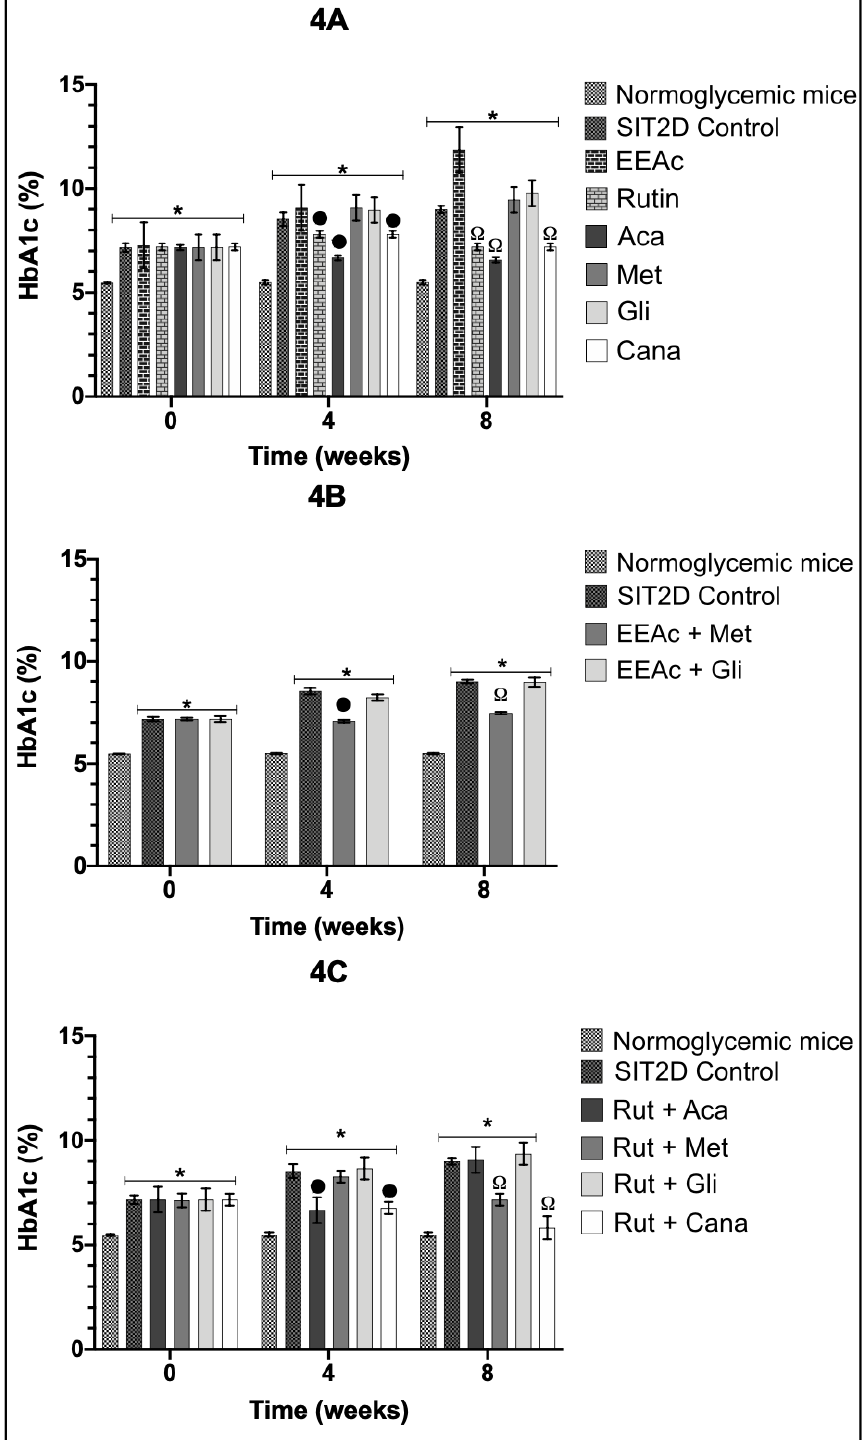
Figure 4. Effect over % glycated hemoglobin (% HbA1c), values after administration of the treat- ments separately and in combination. Groups administrated with treatments separately ( 4A ), groups administrated with the combination of oral antidiabetic drugs and EEAc ( 4B ), groups ad- ministrated with the combination of oral antidiabetic drugs and rutin ( 4C ). Results are expressed as the mean ± SEM, n = 6, * p < 0.05 vs. Normoglycemic mice at same week of treatment; • p < 0.05 vs. SIT2D control in week 4; Ω p < 0.05 vs. SIT2D in week 8.